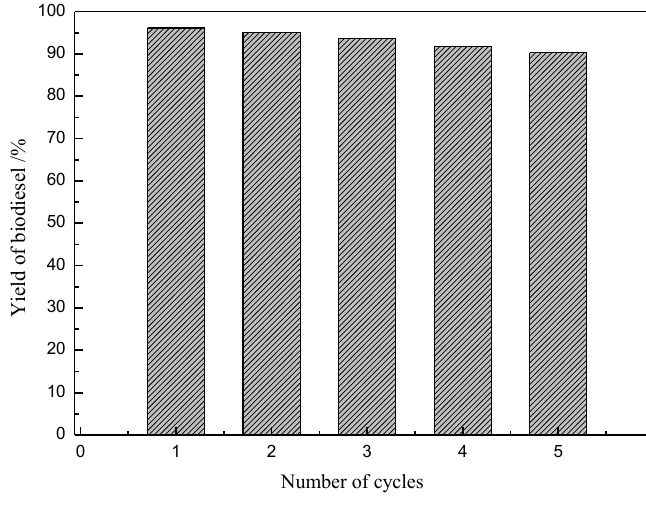
Figure 7. Recycling ability tests of [Hnmm]OH. Reaction conditions: